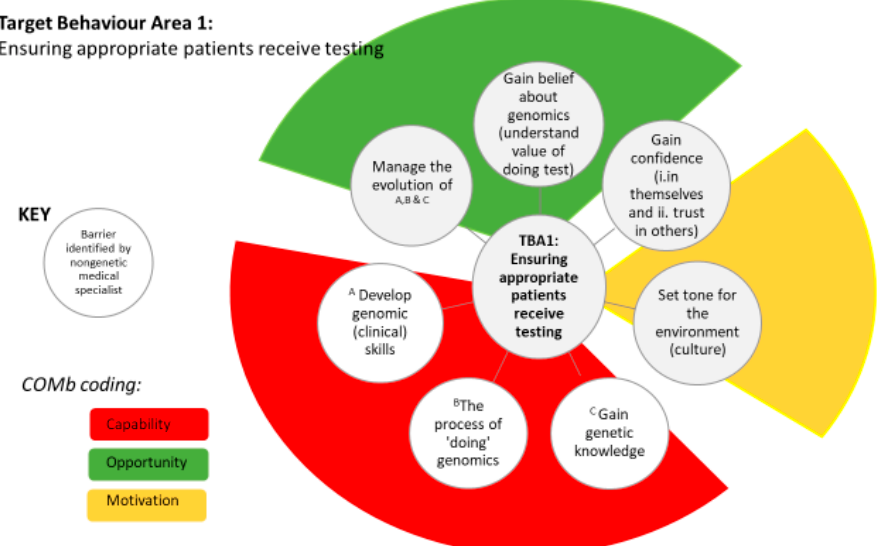
Figure 2. Target behaviour area 1 barriers: demonstrating ease communication through coding by the Capability, Opportunity and Motivation Behaviour framework.